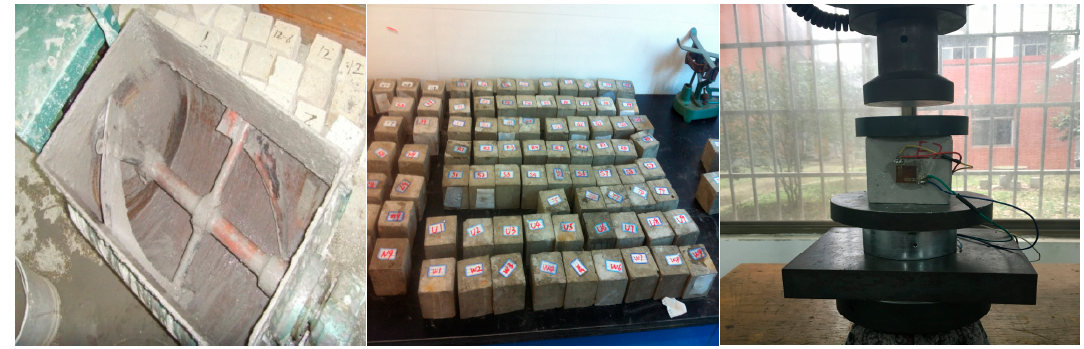
Figure 13. Backfill strength test.